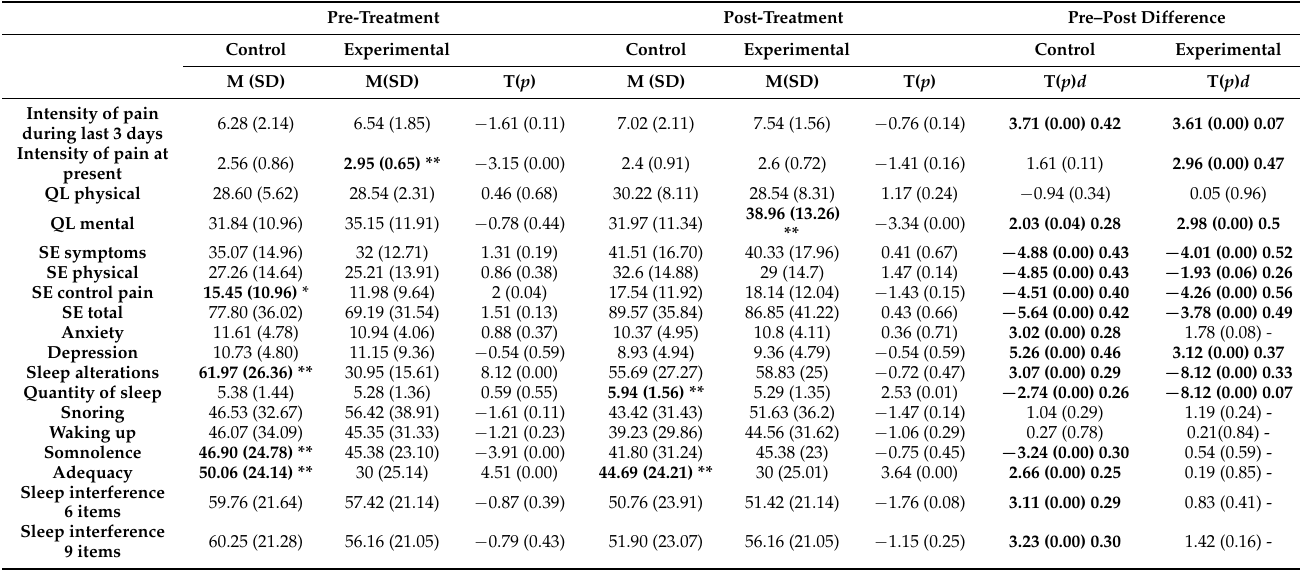
Table 3. t -test results of the differences in pre-treatment and post-treatment means from the control and experimental group. t -test differences and effect sizes (d) for intragroup differences in the experimental group and treatment.